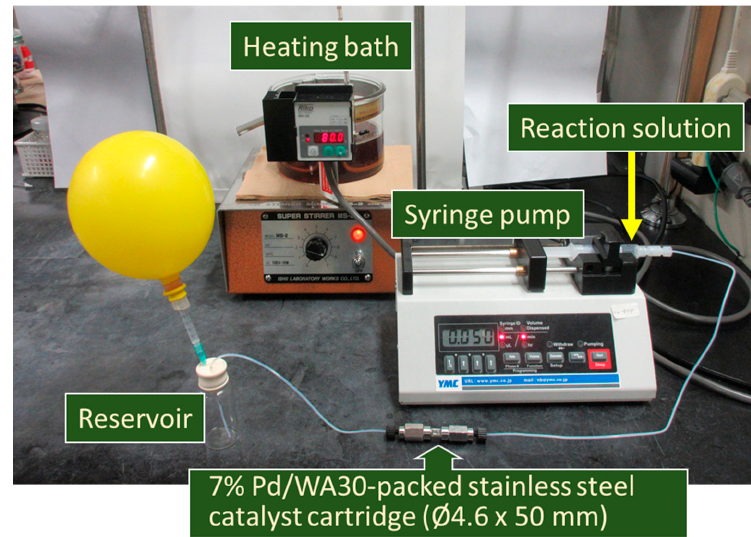
Figure 1. Continuous-flow apparatus for the Suzuki–Miyaura coupling reaction using a 7% Pd/WA30- packed catalyst cartridge.